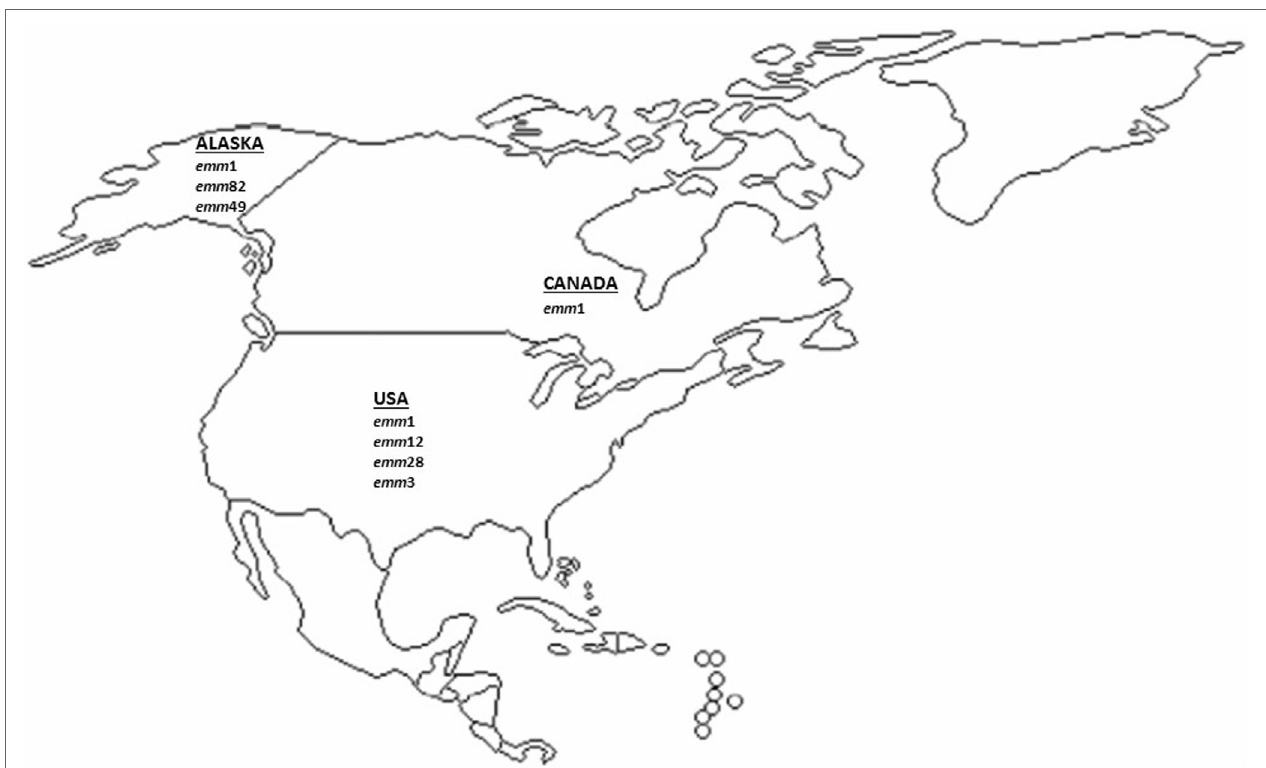
FiGURe 2 | Most prevalent invasive GAS emm -types described in North America (US and Canada) since 2000 onward. The major emm types (accounting for approximately ≥ 10% of all emm types) from the US and Canadian studies included in this analysis are